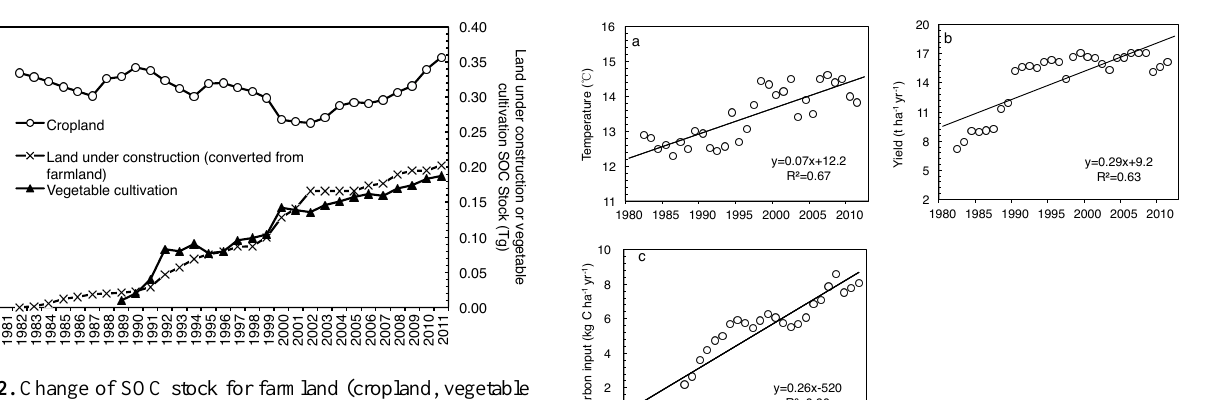
Figure 2. Change of SOC stock for farmland (cropland, vegetable land, farmland converted to construction land) from 1982 to 2011 in Huantai County.